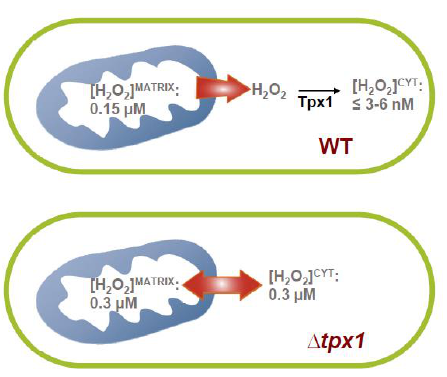
Figure 6. Scheme depicting the main finding of the use of the roGFP2-Tpx1.C169S and HyPer7 reporters in the quantification of basal and induced H 2 O 2 levels and inter-compartmental H 2 O 2 gradients. See Discussion for details.